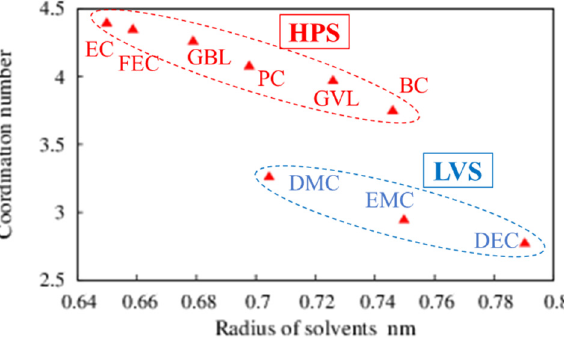
Figure 3. Comparison of solvation shell. ( a ) EC + 1M-LiPF 6 ; ( b ) DMC + 1M-LiPF 6 .